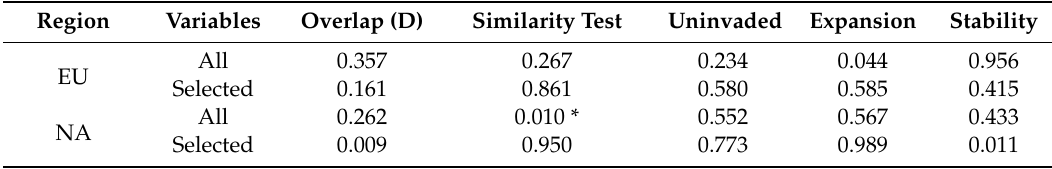
Table A3. Summary of p values for the niche test of Sudden oak death between the presumed native range Indochina (Vietnam) and invasive ranges Europe (EU) and North America (NA) using all and selected climatic variables. Bold values represent niche comparison values between native versus each introduced ranges (1 → 2) whereas unbolded values represent comparisons between introduced ranges versus native range (2 → 1). Significant p -values ( α = 0.05) are represented by